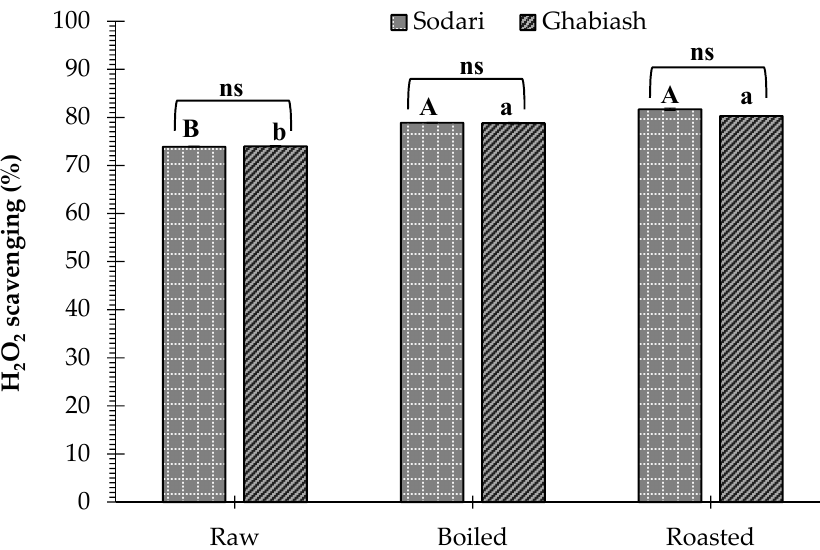
Figure 5. Hydrogen peroxide (H 2 O 2 ) scavenging ability of boiled and roasted peanut cultivar shells. Data represent mean ± SD ( n = 3). Values followed by the same letter are not significantly different ( p < 0.05) as evaluated by LSD. Capital letters indicate significant differences between raw and processed samples of Sodari cultivars, whereas lower case letters indicate significant differences between raw and processed samples of Ghabiash cultivar. * shows the significant differences between means of cultivars, while ns shows the insignificant differences between means of cultivars in the raw and processed samples.